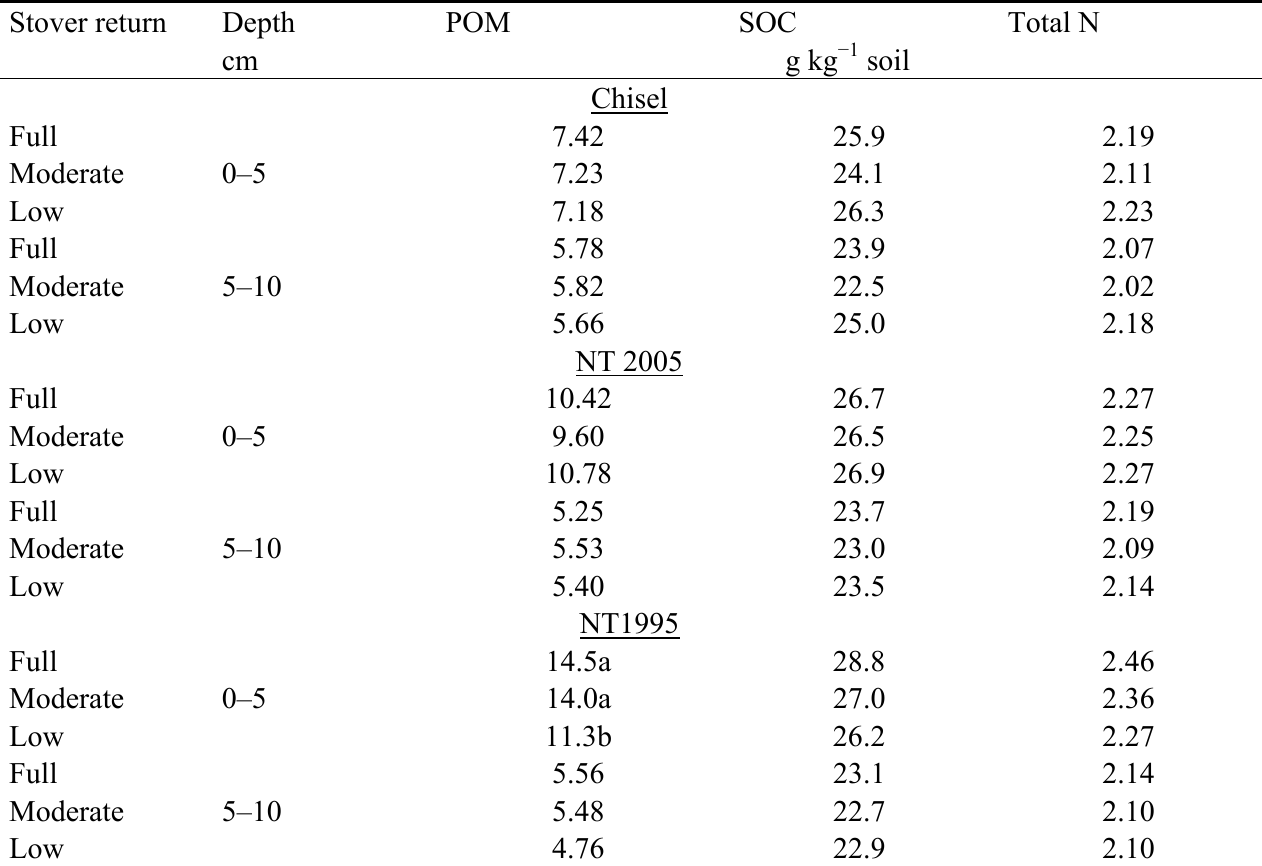
Table 4. Effect of stover return rate on particulate organic matter (POM), soil organic carbon (SOC) and total N. Means within a column followed by different letters differ at P ≤